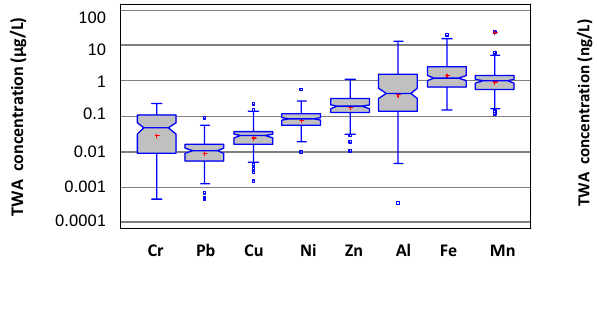
Fig. 2 Distribution of time weighted average concentration of met- als and PAHs in the Saulx and Ornain Rivers. Boxes extend from the 25th to the 75th quartile. The median and the mean are respec-